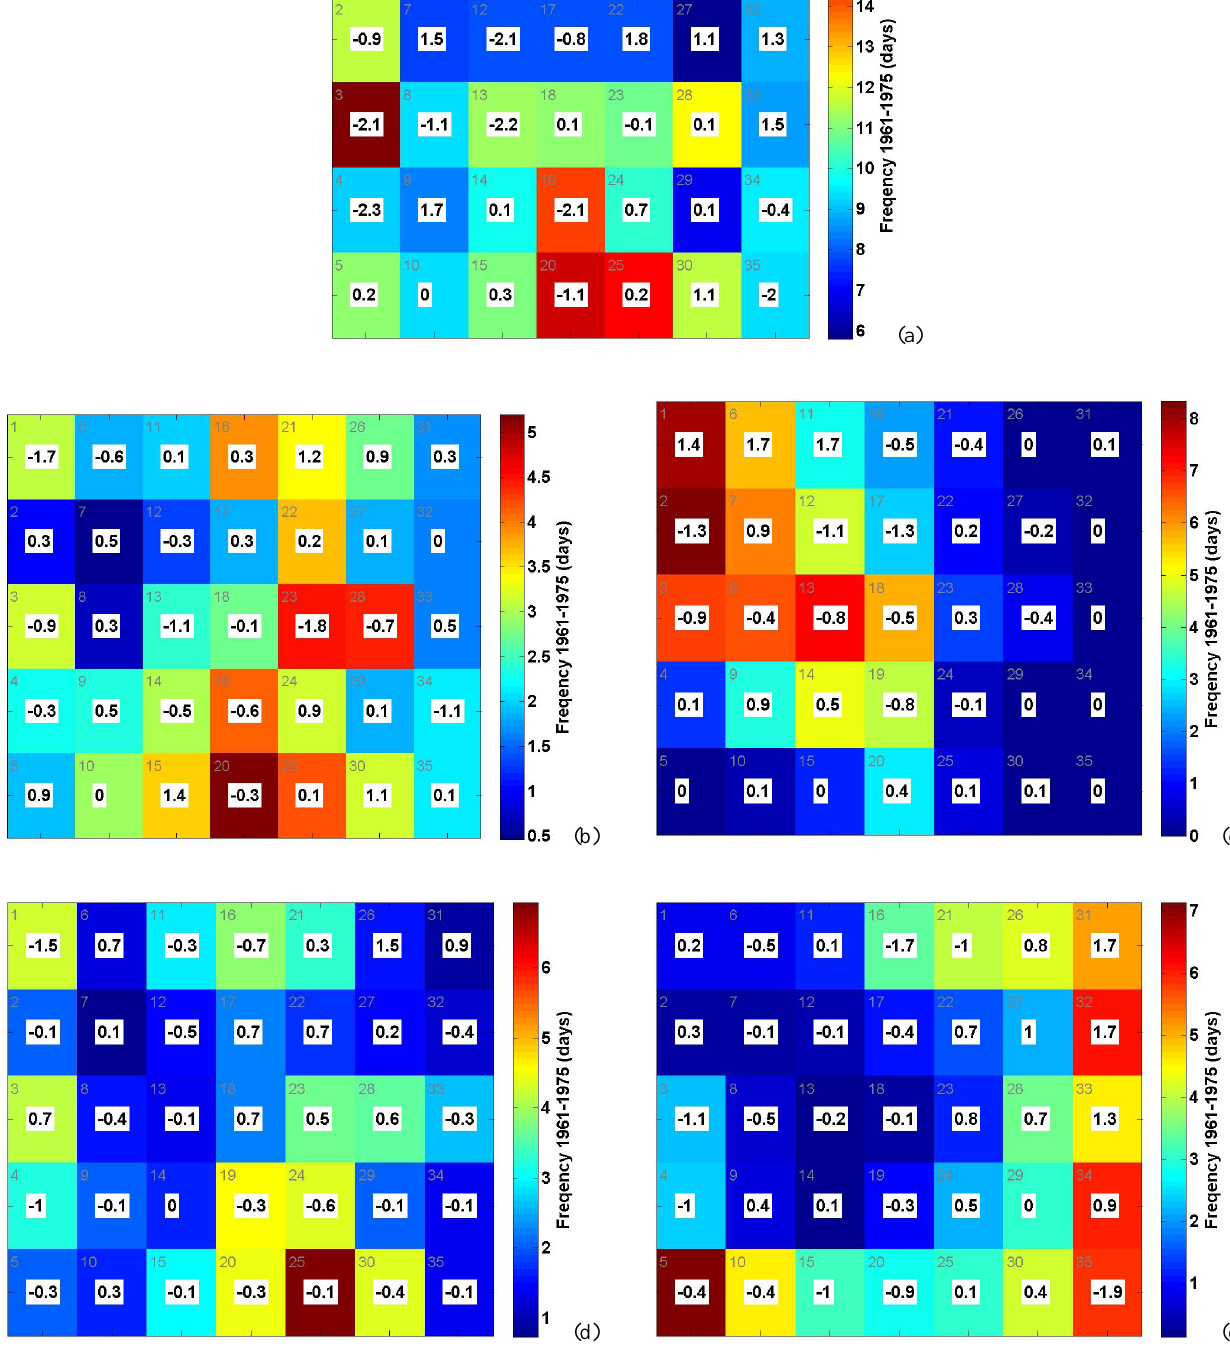
Fig. 10. (a) Annual, (b) MAM, (c) JJA, (d) SON, and (e) DJF change in average pattern frequency between means of 1995–2009 and 1961–1975. Text shows change in number of days and colors show pattern frequency during the first period to aid in assessing percentage of